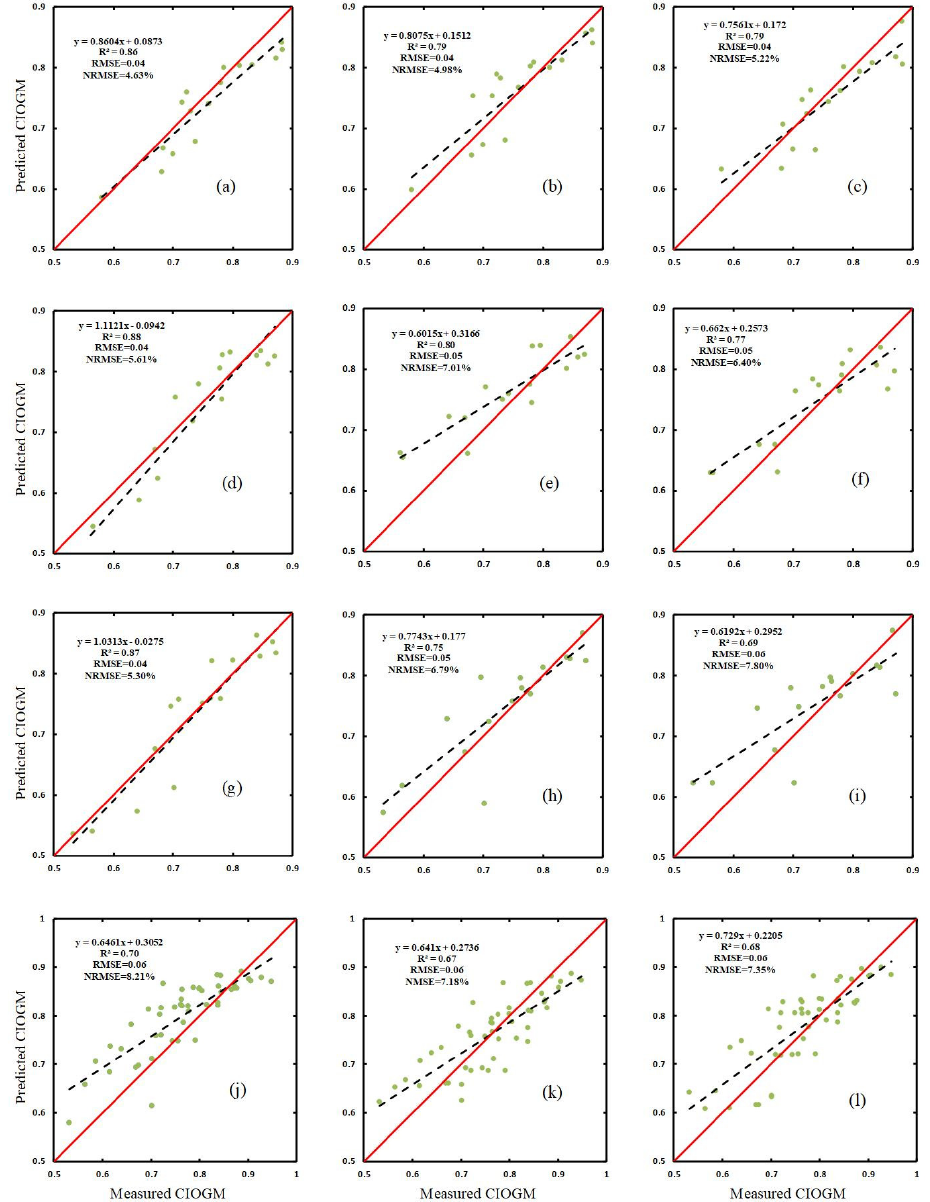
Figure 4. Relationship between the CGI predicted vs. the CGI measured by Spectral VIs using ( a – c ) MLR, PLSR, and RF models at (GS 31), respectively; ( d – f ) MLR, PLSR, and RF models at (GS 47), respectively; ( g – i ) MLR, PLSR, and RF models at (GS 65), respectively; and ( j – l ) MLR, PLSR, and RF models over the three stages, respectively.